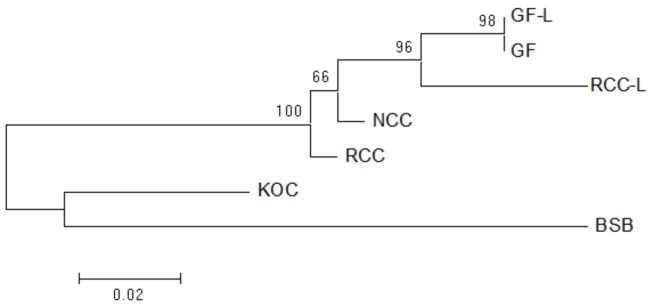
Maximum likelihood tree inferred from 5S rDNA sequences. This tree illustrates the phylogenetic relationships among 5S rDNA sequences in KOC, BSB, RCC-L, NCC, GF-L, RCC, and GF. The numbers at the branch nodes indicate the bootstrap percentage.